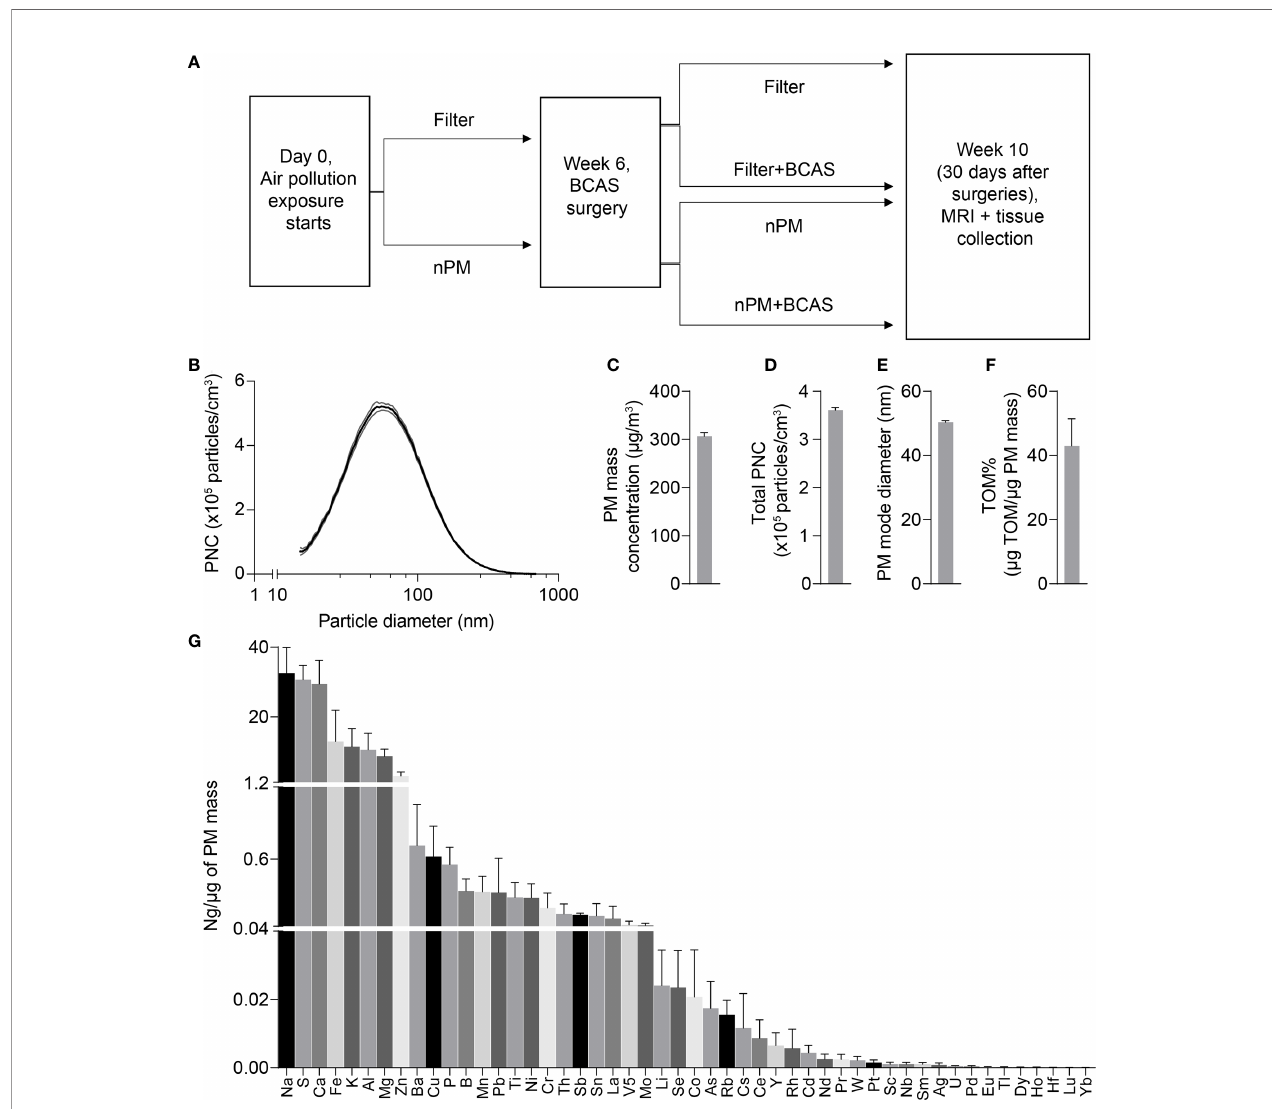
FIGURE 1 | Design of the study and physicochemical properties of nPM used in exposure studies. (A) Experimental timeline of air pollution exposure and surgical procedures. (B) Particle size distribution of the collected exposure aerosol. (C) Particulate matter mass concentration (µg/m 3 ), (D) Total particulate number concentration (x10 5 #/m 3 ), (E) Particle mode diameter (nm), (F) Total mass of organic matter (% of particulate matter mass) and (G) Mass fractions of trace elements and metals (ng/µg of particulate matter mass) during exposures. Data is presented as mean ± standard deviation in panel (B) and mean ± standard error in panels (C – H) . (n)PM, (nano)particulate matter; BCAS, bilateral carotid artery stenosis; MRI, magnetic resonance imaging; PNC, particulate number concentration; TOM, total mass of organic